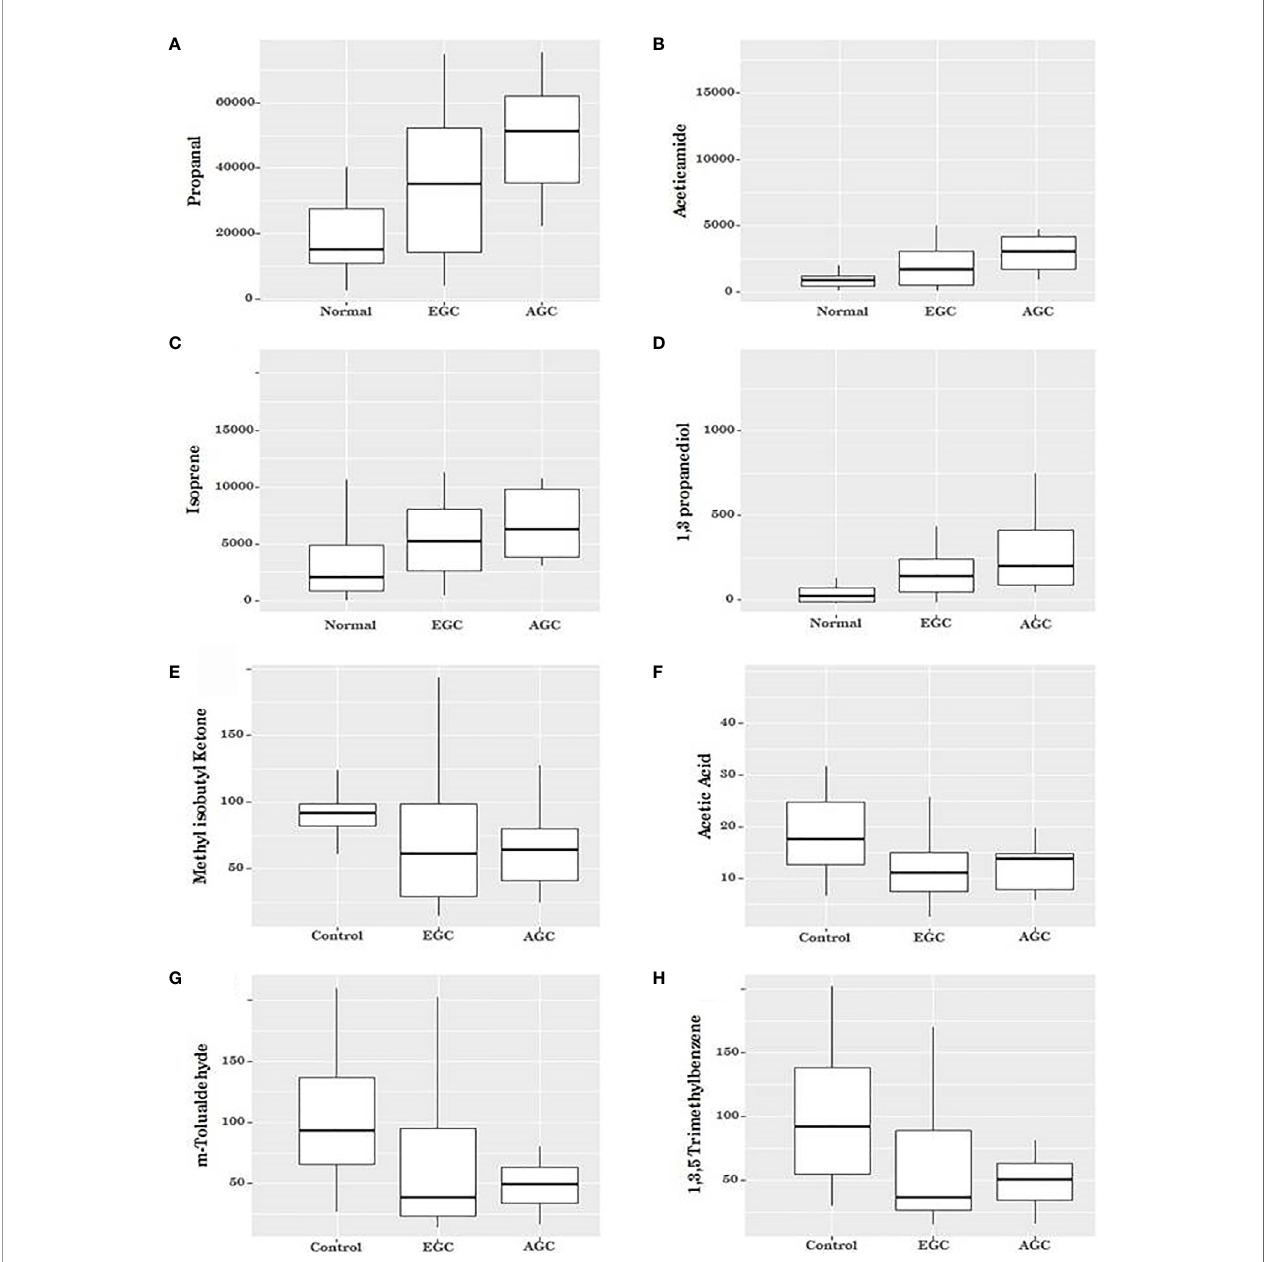
FIGURE 2 | Box plot for the volatile organic compounds (VOCs) according to cancer status. (A – D) When patients were grouped according to cancer stage, four VOCs were seen to gradually increase as cancer advanced (Propanal, Aceticamide, Isoprene, and 1,3 propanediol, respectively ( P = 0.003, P = 0.007, P = 0.020 and P = 0.025, respectively). (E, F) The two the VOCs showed no signi fi cant differences among the three groups (methyl isobutyl ketone, P = 0.998 and acetic acid, P = 0.050). (G, H) Two of the VOCs that were lower in cancer patients than in controls showed signi fi cant differences among the three groups, but these were not correlated with cancer stage (m-tolualdehyde, P = 0.021, and 1, 3, 5-trimethylbenzene, P =